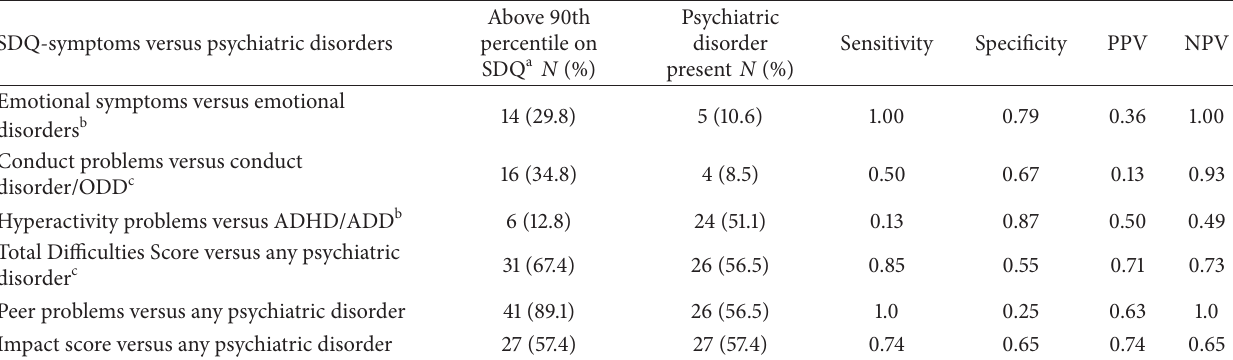
Table 4: Mental health screening compared to having a psychiatric disorder (according to DSM-IV criteria assessed by Kiddie-SADS) for children with cerebral palsy at school starting